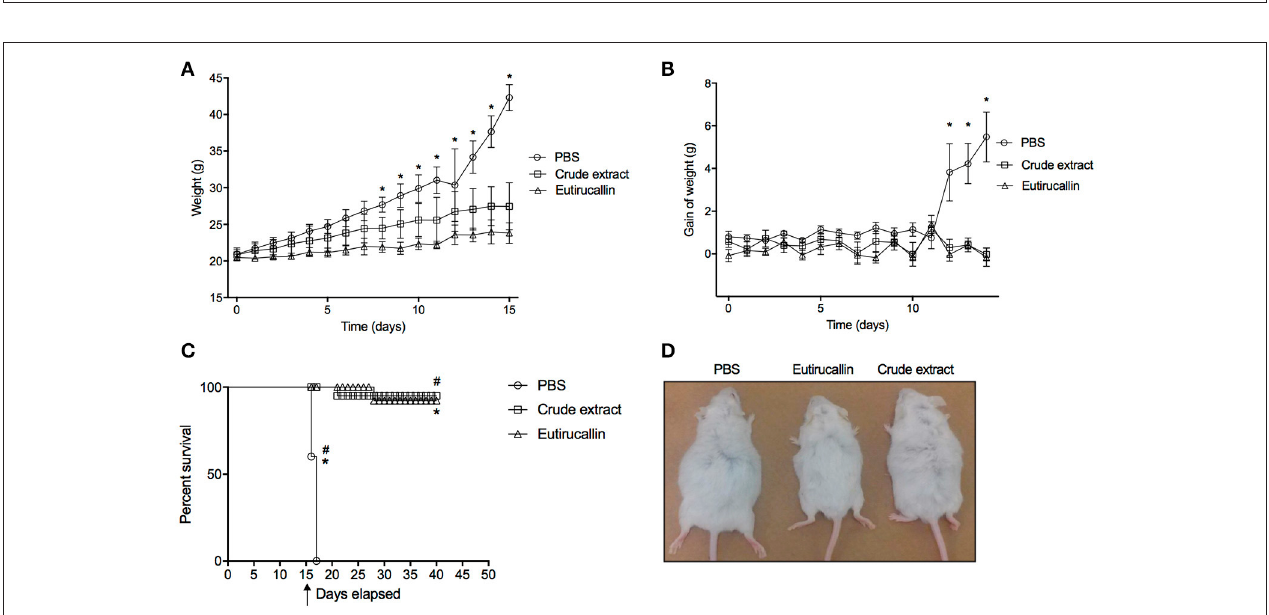
FIGURE 5 | Proliferative results obtained from the HeLa colony counts after treatment with crude extract (A) and Eutirucallin (B) . Both components continued to exert antiproliferative effects after removal from the cell culture. Bars represent standard errors; * P < 0.05 relative to the control.